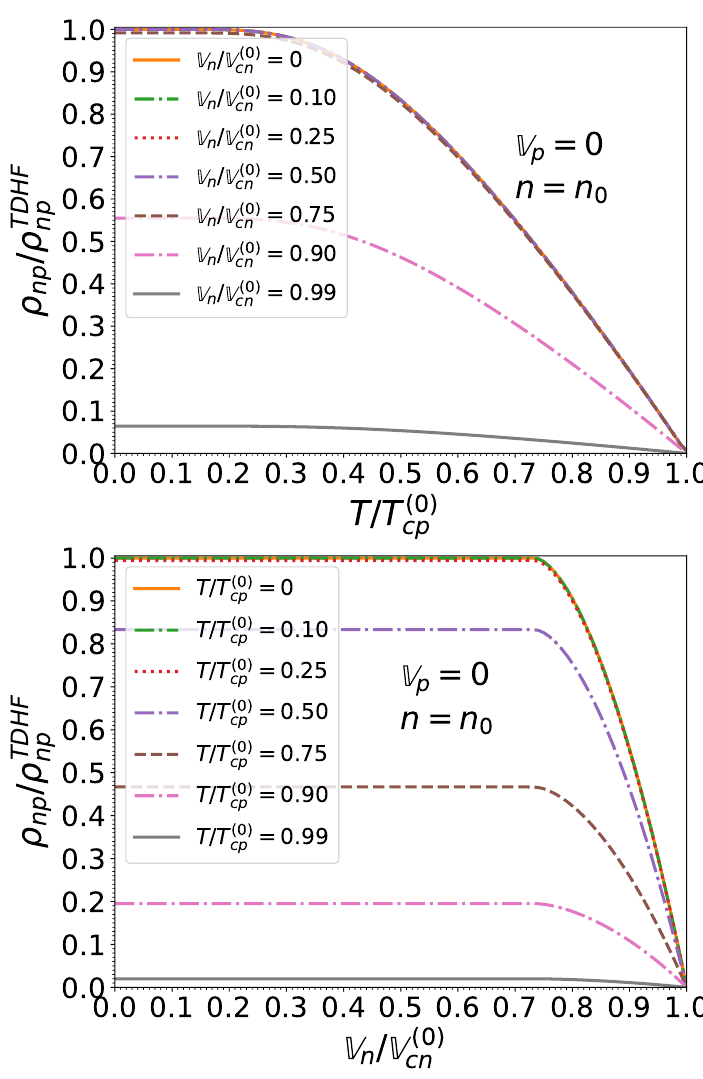
Figure 17. Same as Figure 14 at the saturation density n 0 .